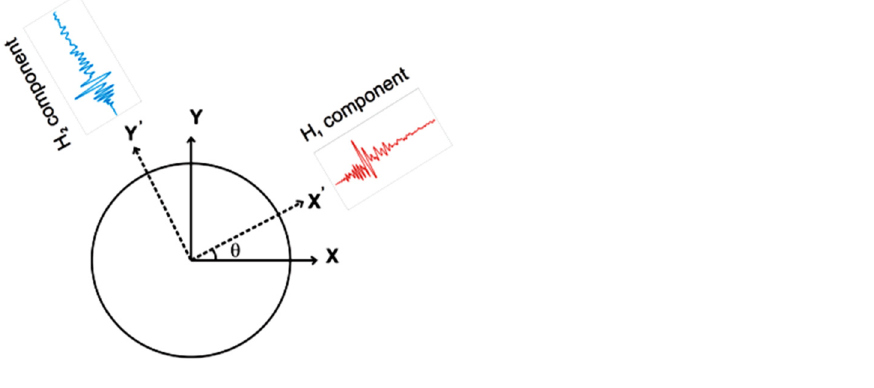
Figure 10. Applying two horizontal components of the records, H 1 and H 2 , along X’ and Y’ axes rotated by θ ° relative to the principal axes of structure, X (longitudinal direction) and Y (transverse direction).